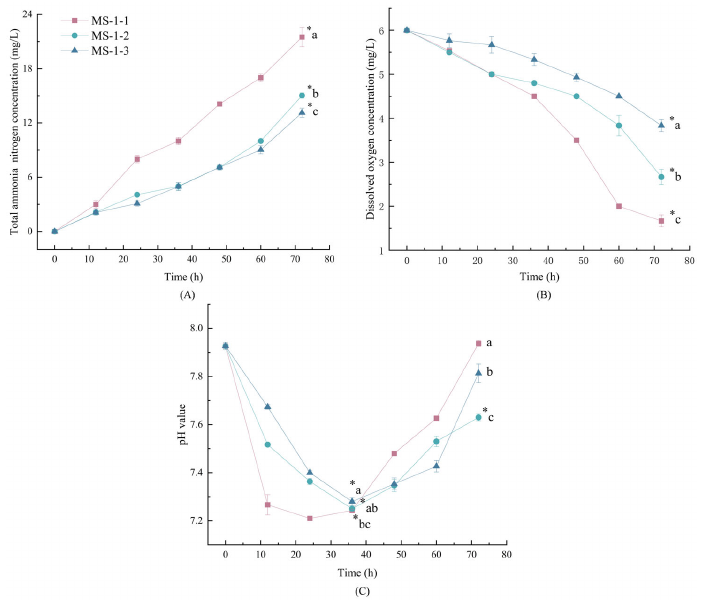
Figure 3. The changes in total ammonia nitrogen concentration ( A ), dissolved oxygen concentration ( B ), and pH value of transport water ( C ) in different treatment samples during live transport. Vertical bars indicate standard deviation. Asterisk (*) represents significant differences ( p < 0.05) at transporting for 0 h and after transport. Different lowercase letters represent significant differences among three treatment samples at the same time during live fish transport.